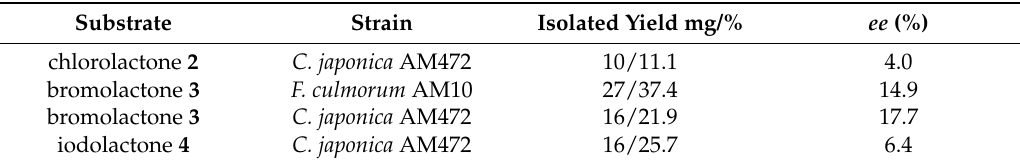
Table 3. Results of preparative biotransformation of lactones 2 – 4